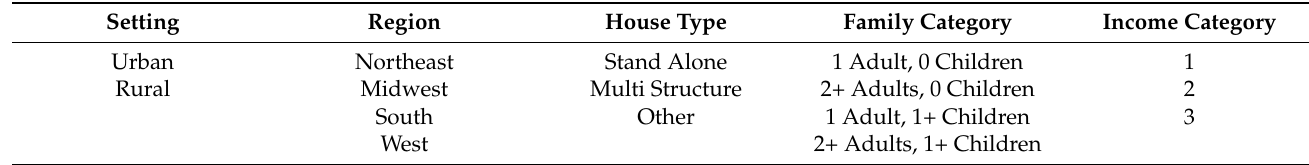
Table 3. Assembly of 288 possible household